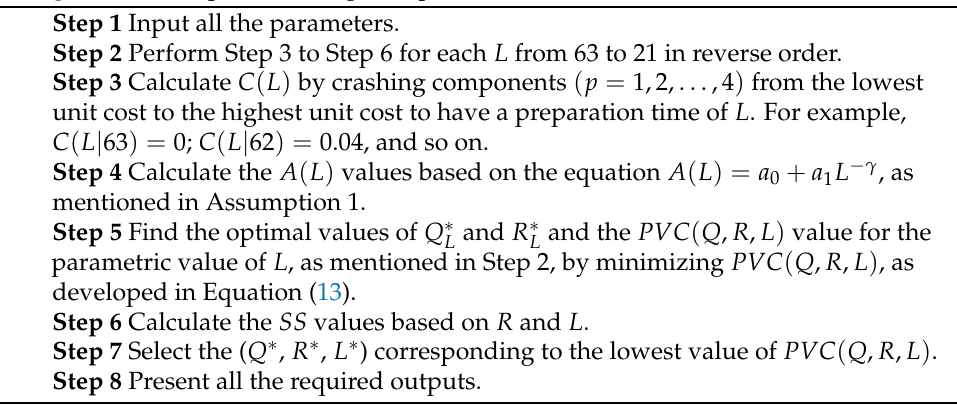
Algorithm 1: Steps for finding the optimal solution for the stochastic